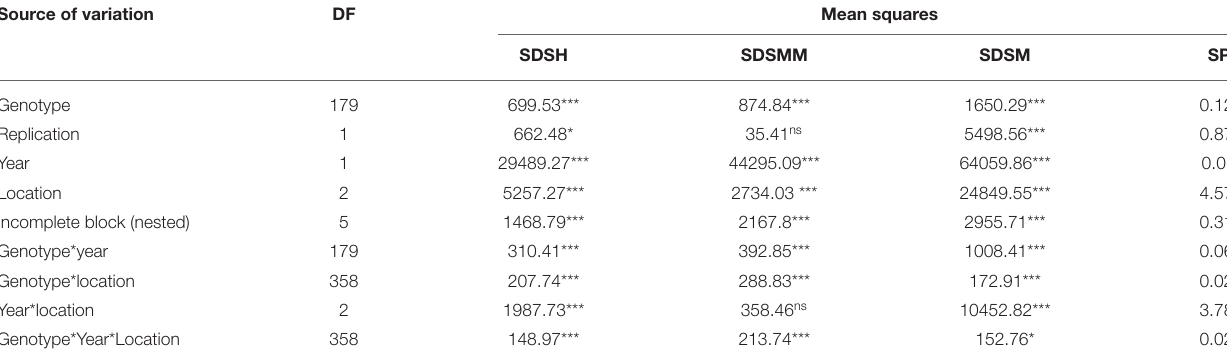
TABLE 3 | Combined analysis of variance for Septoria disease severity traits across three locations in Ethiopia over years 2015 and 2016. Source of variation DF Mean